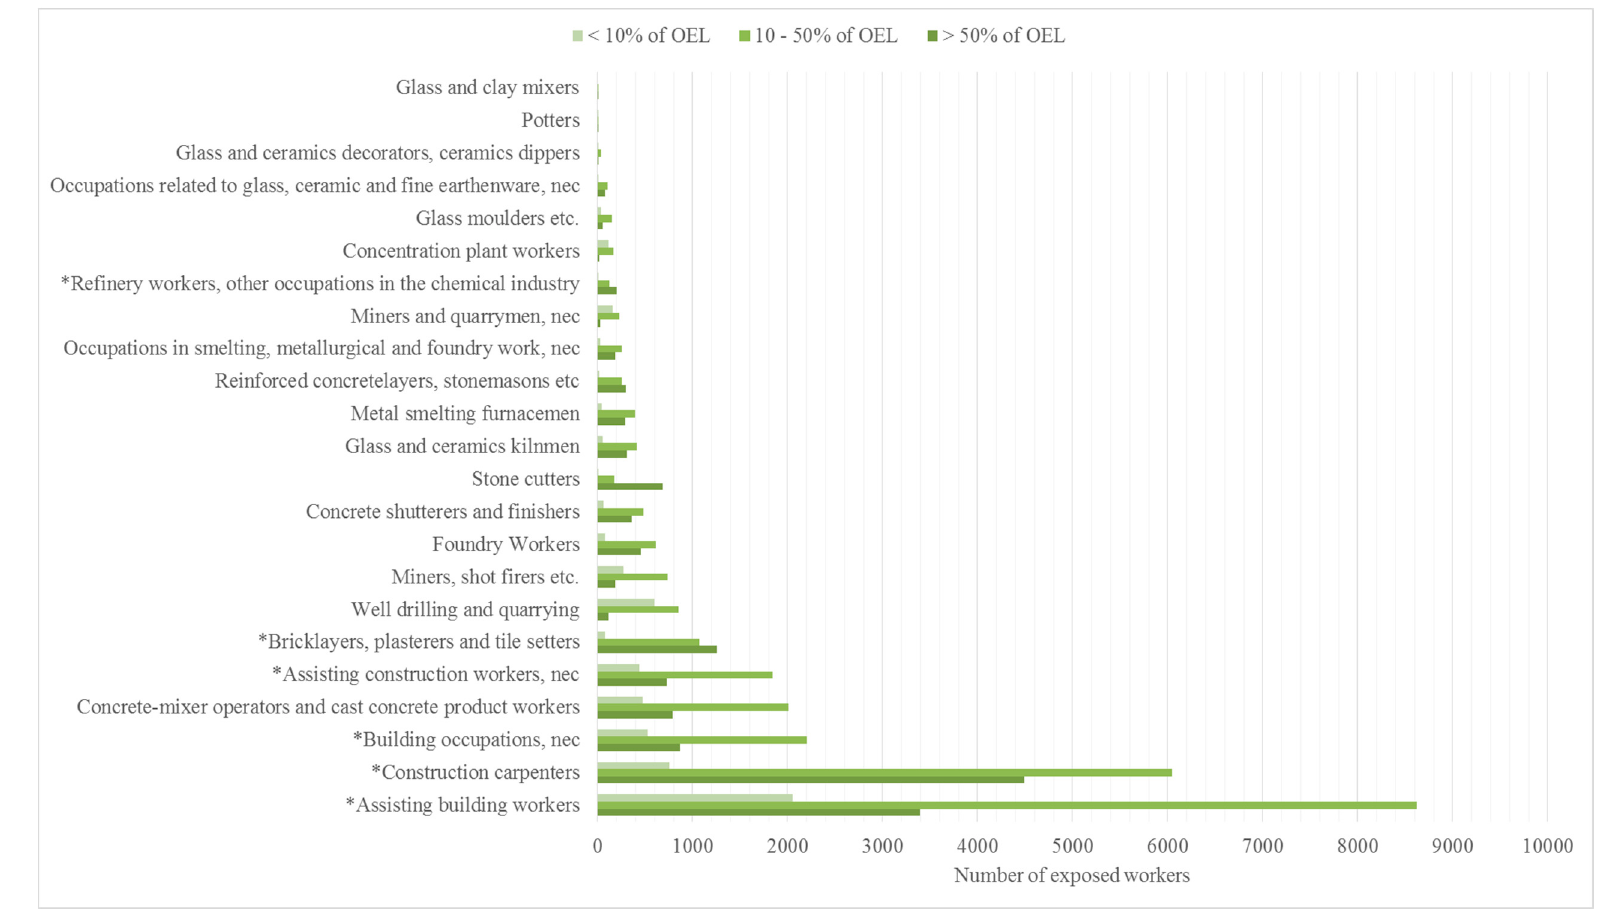
Figure 3. Respirable quartz concentrations in different occupations in relation to the OEL 8h during 2013–2015 according to FINJEM (* not formally covered by the NEPSI treaty).